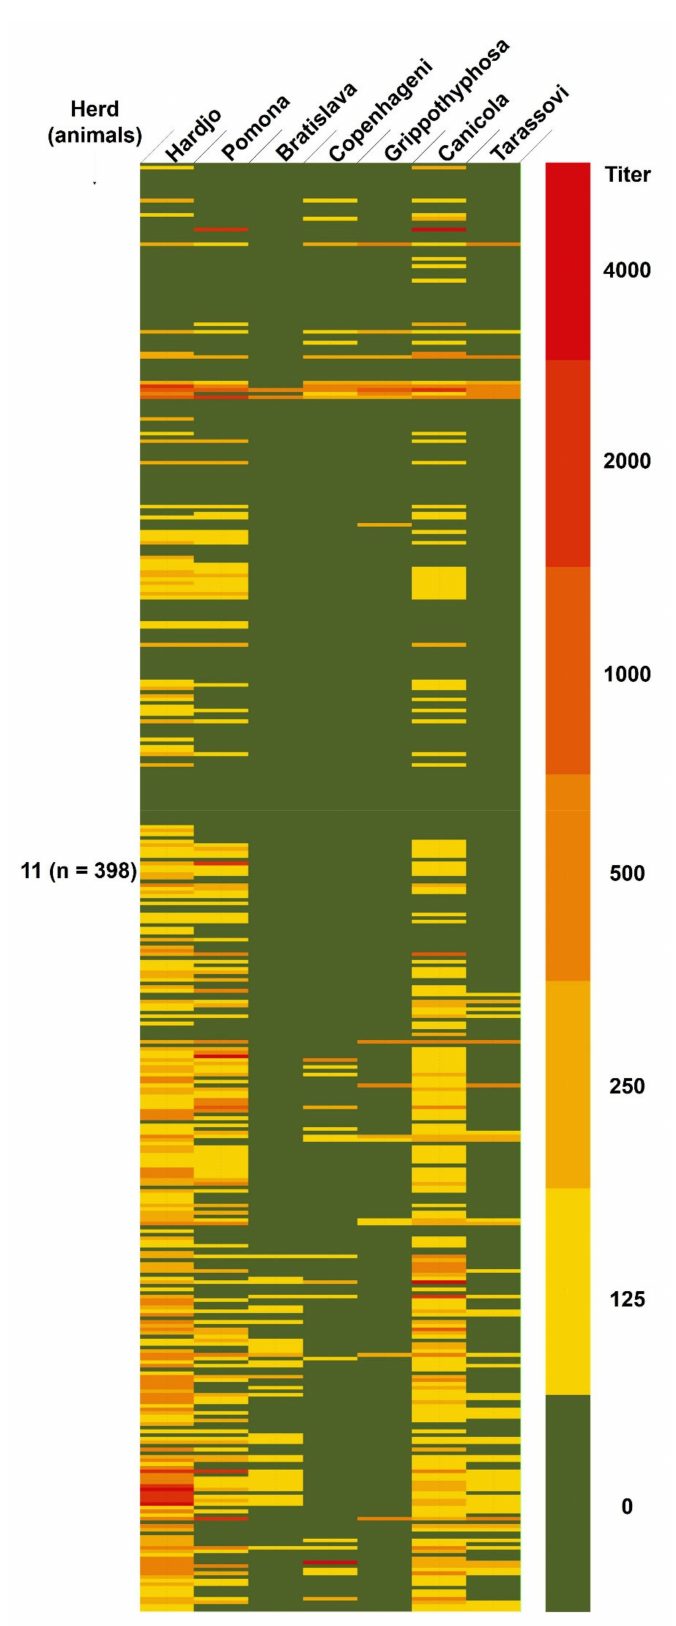
Figure 3. Heat map of MAT seropositivity to the different serovars of Leptospira in the vaccinated